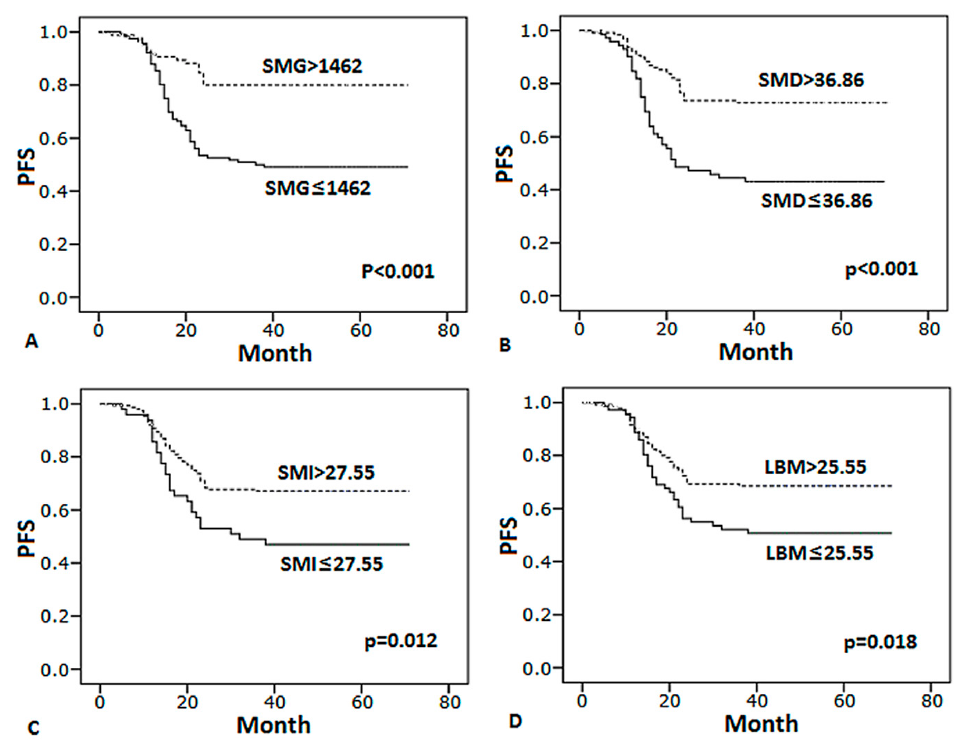
Figure 3. Kaplan–Meier curves of PFS for patients by body composition. ( A ) SMG (skeletal muscle gauge), ( B ) SMD (skeletal muscle density), ( C ) SMI (skeletal muscle index), ( D ) LBM (lean body mass).